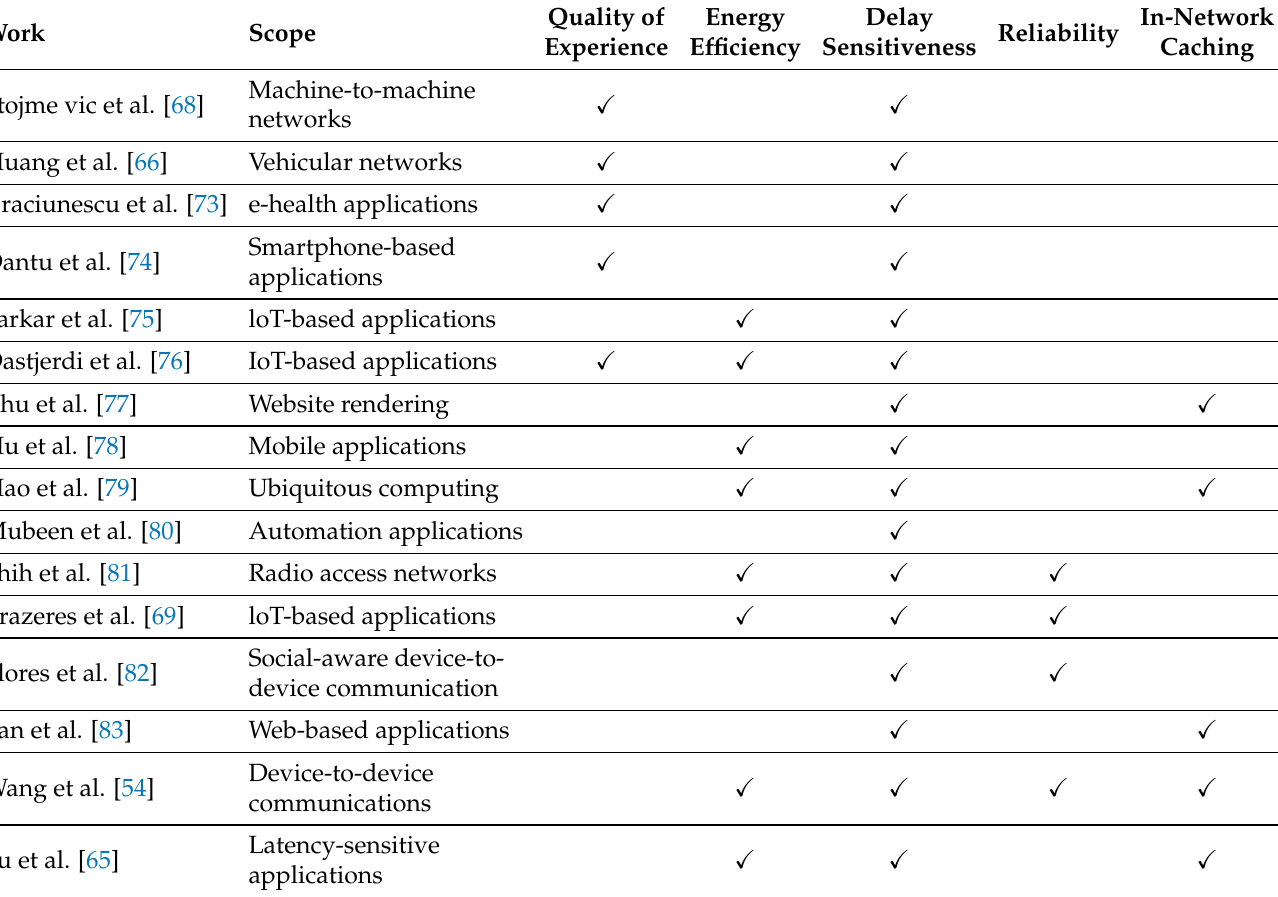
Table 2. Comparison of QoS aspects from various